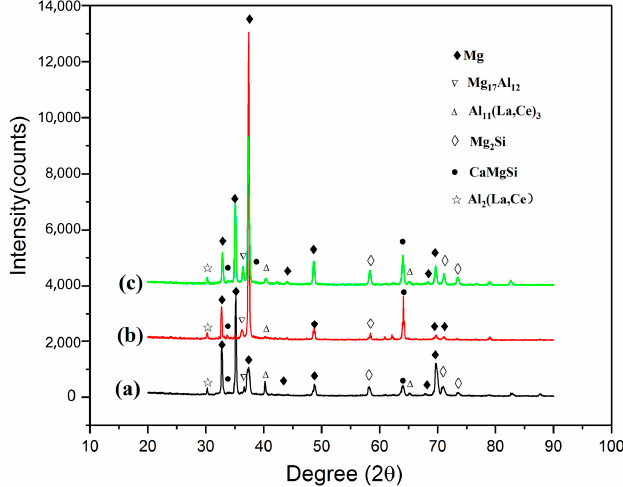
Figure 2. The XRD patterns of the as-cast AZXSE91000 sample for ( a ), solution-treated sample for ( b ) and as-extruded sample for ( c ).